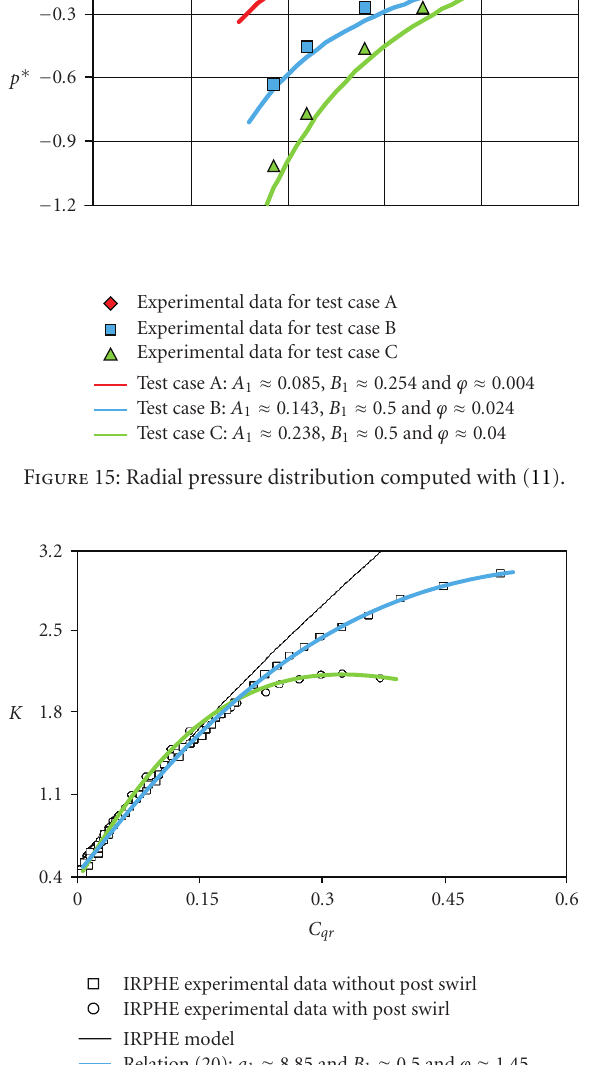
Experimental data for test case A Experimental data for test case B Experimental data for test case C Figure 14: Core swirl ratio distribution.